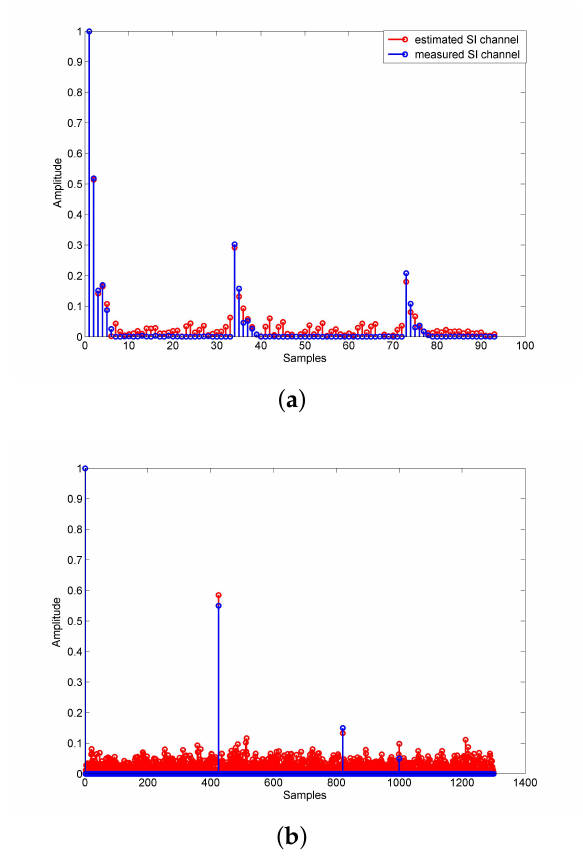
Figure 14. The comparison of measured and estimated SI/intended channel response: ( a ) SI channel; ( b ) intended channel.